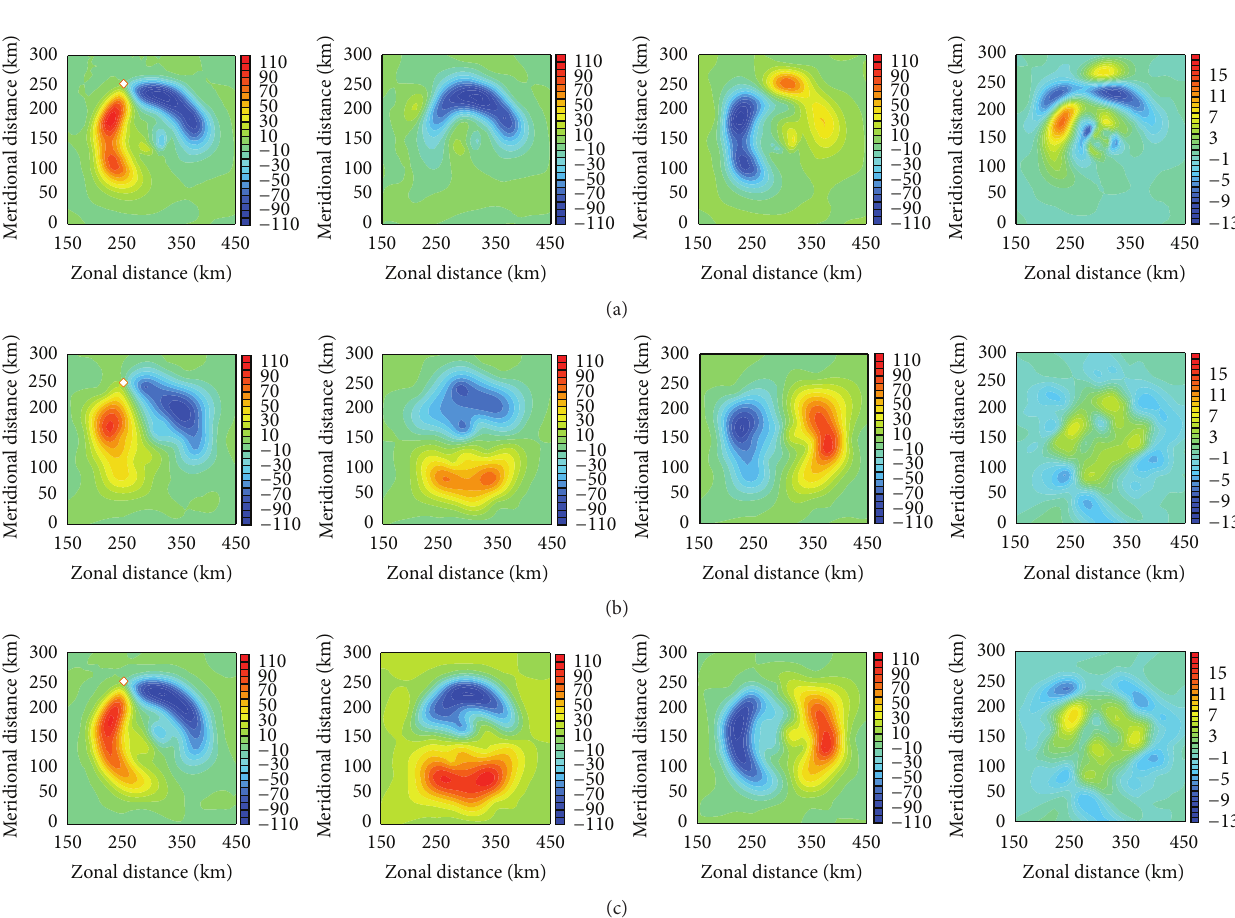
Figure 2: STMAS analyses at middle vertical level. From left to right, these columns represent radial wind, U component, V component, and W component, respectively. (a) is the results by only assimilating radial wind data. (b) is the results by assimilating only coarse conventional data. (c) is the results by assimilating both radial wind data and coarse conventional data (unit: